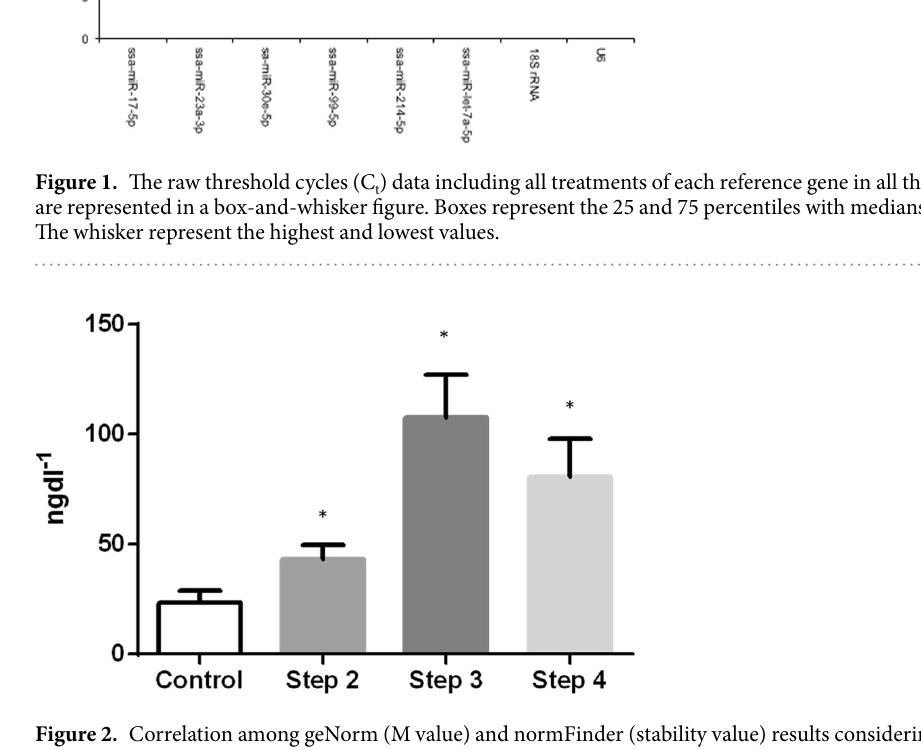
Figure 2. Correlation among geNorm (M value) and normFinder (stability value) results considering the pooled